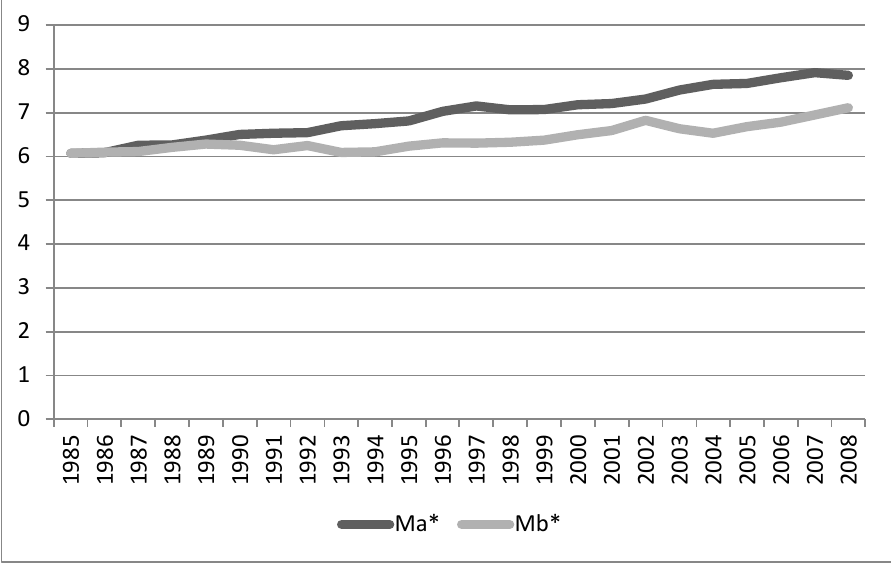
FIGURE 4: Plotting the reaction function from 1985 to 2008, using 1985 as the base year Source: Author’s